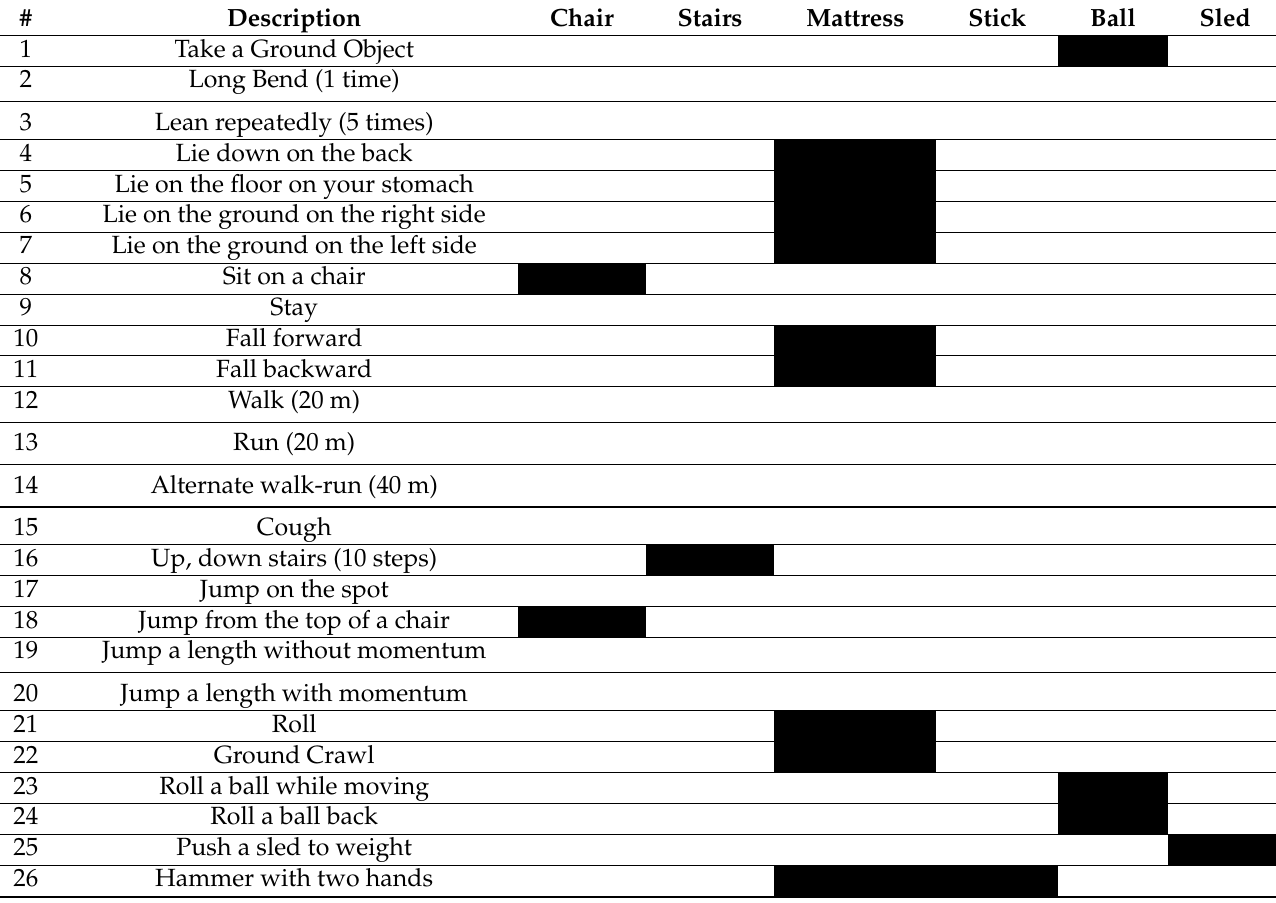
Table 1. Workers physical test